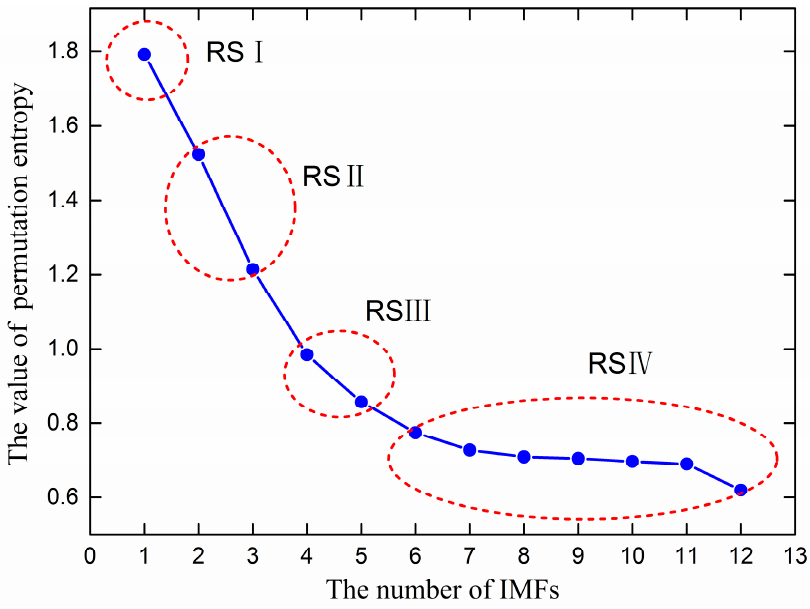
Figure 6. The permutation entropy values of IMFs.